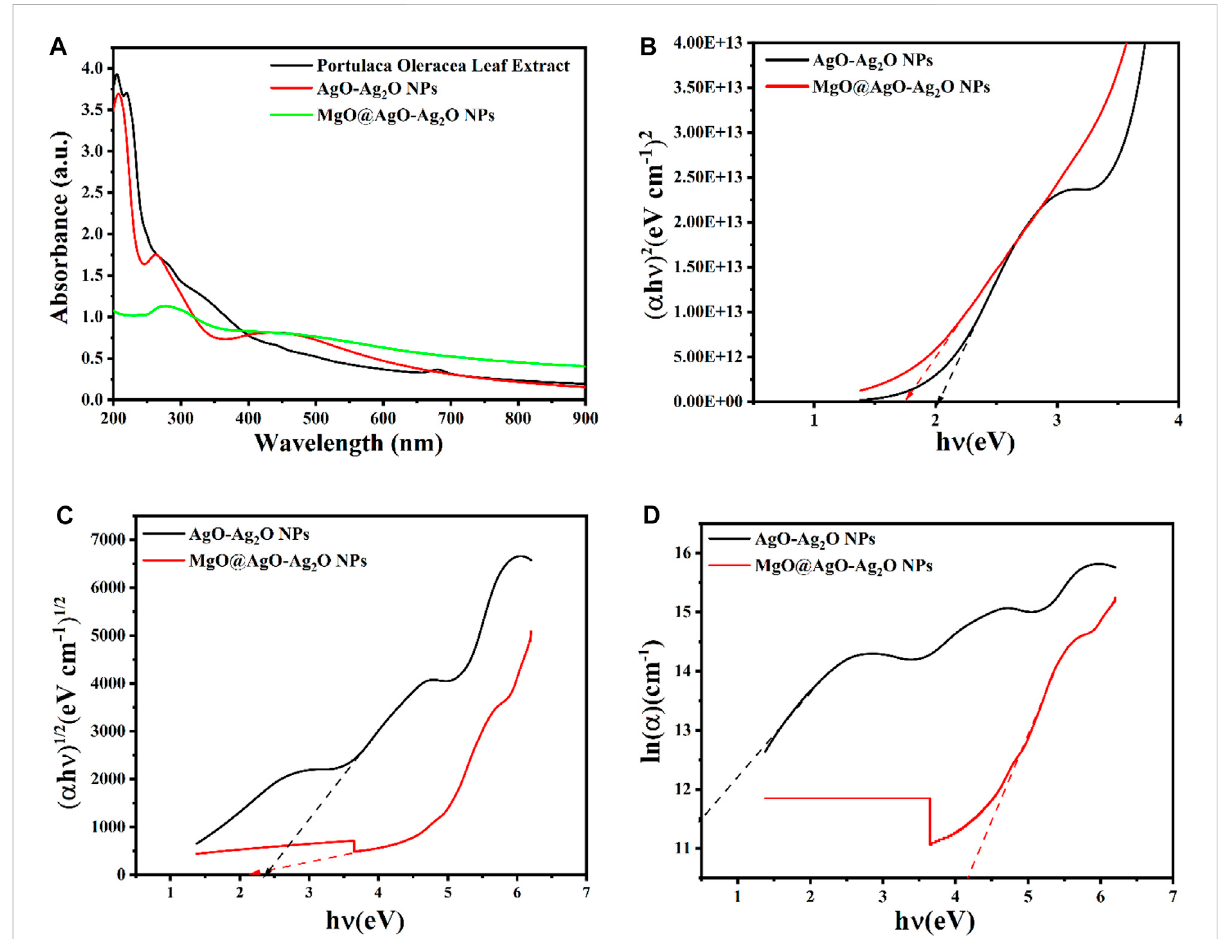
FIGURE 6 UV-visspectraof (A) Extract, AgO/Ag 2 O, and MgO@AgO/Ag 2 O (B) Opticalenergygapfor direct, (C) Indirect transitions, and (D)